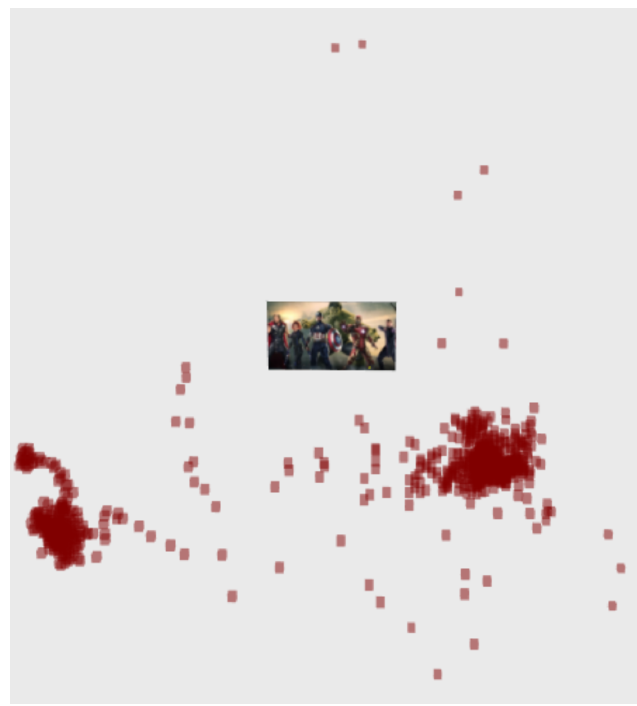
Figure 20. User positions from the bad tracking examples. Perceive the random dots sparsely located over the 3D space. They represent the bad tracking cases from the library used. The big condensed sets (on the left and on the right side) represent places in which the user stood for a higher time in order to prepare for the photo. The movie poster in the center represents the TV position in which the marker is